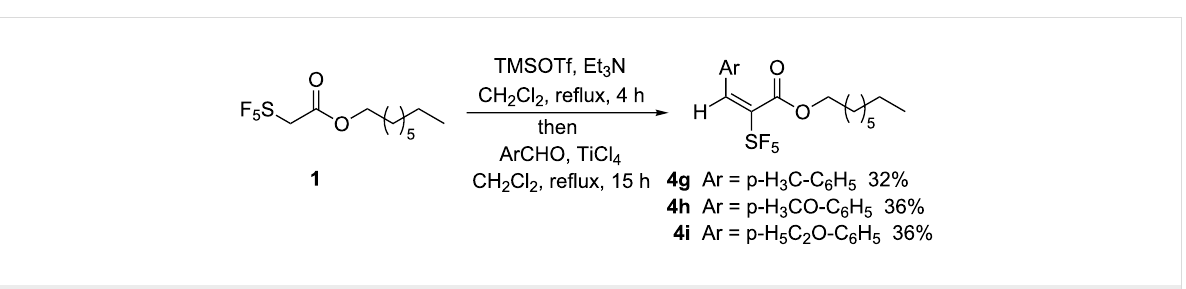
Scheme 2: Mechanism of the formation of aldol addition products.